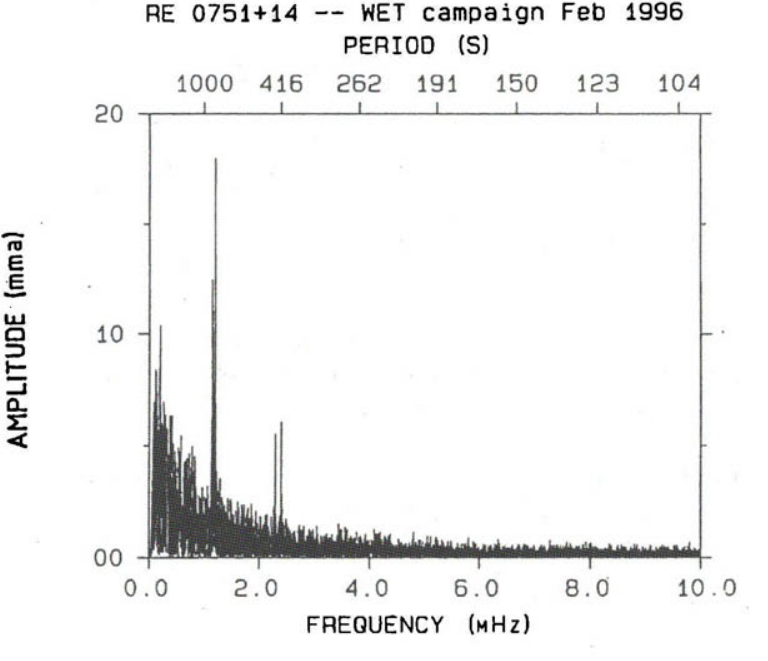
Fig. 1. Fourier amplitude spectrum of the total WET data